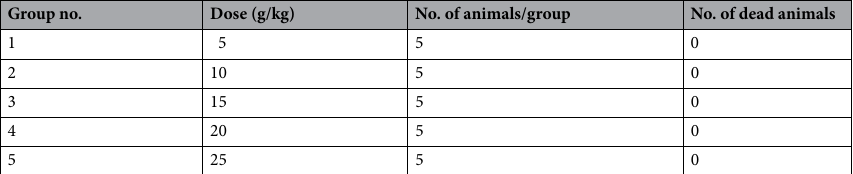
Table 4. Acute oral lethal toxicity of stearyl stearate. Experimental animals were divided into 5 groups of mice (5 mice per each). The applied dose of stearyl stearate was orally administrated up to 25 g/kg body weight. No mortality was recorded for the evaluated groups of mice.